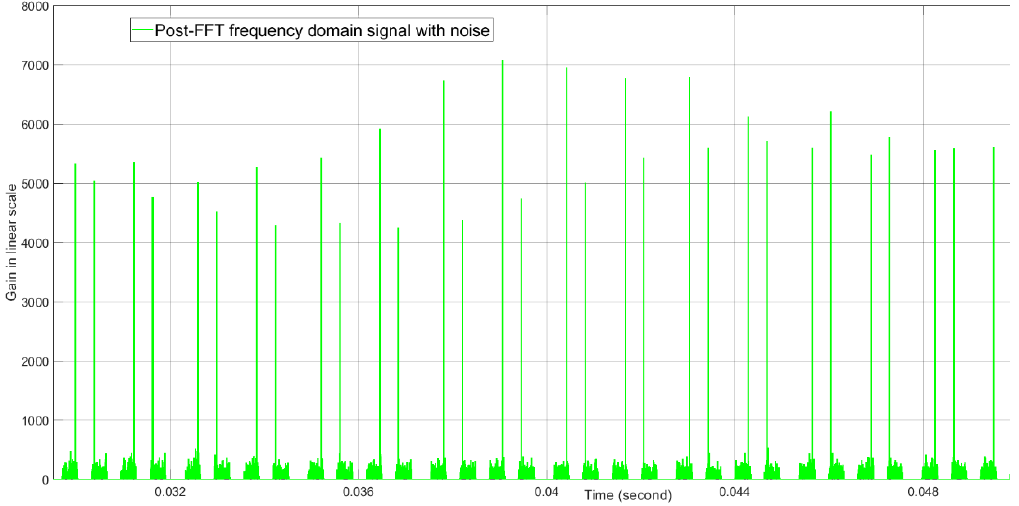
Figure 13. The post-FFT desired tone energy with noise when initial Doppler is equal to the true Doppler at about 0.04 s real time. This result is generated by computer simulation, not by FPGA simulation.